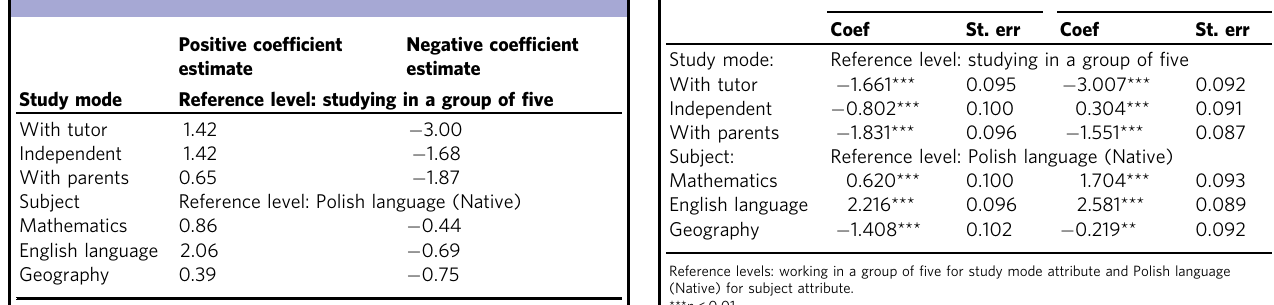
subject attributes for students with positive and negative